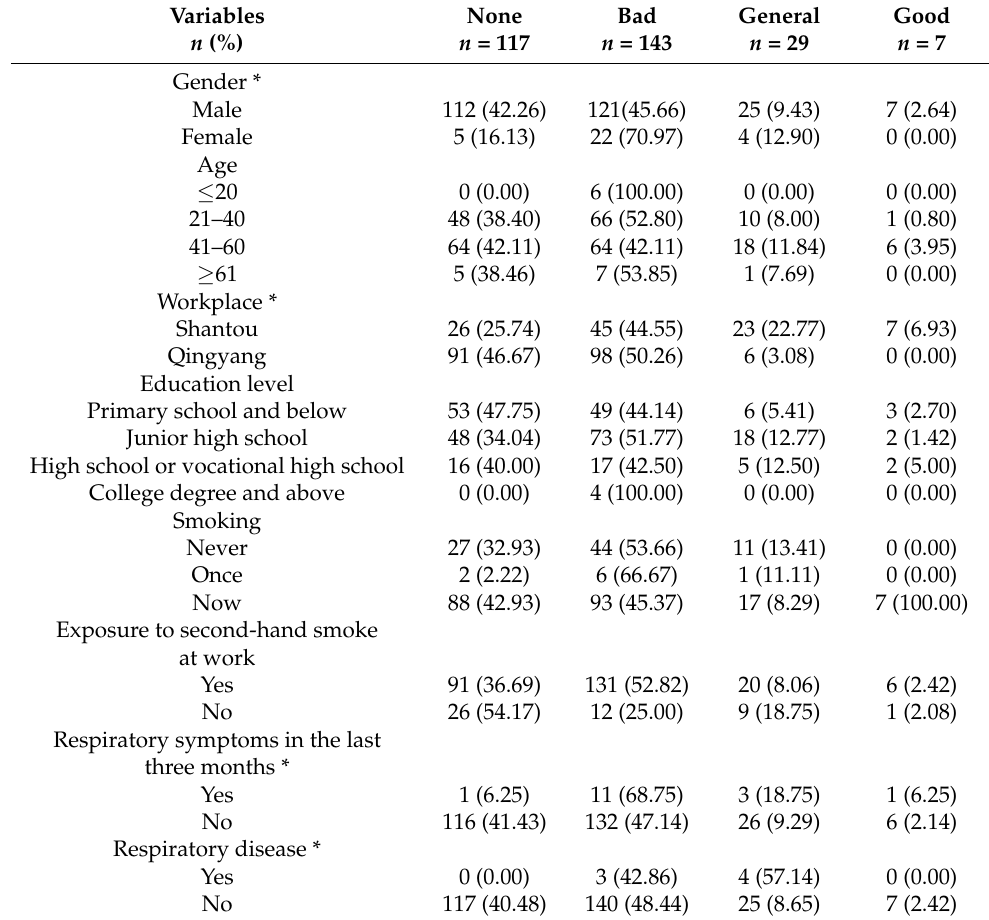
Table 2. Basic information on migrant interior construction workers according to respiratory protec- tion